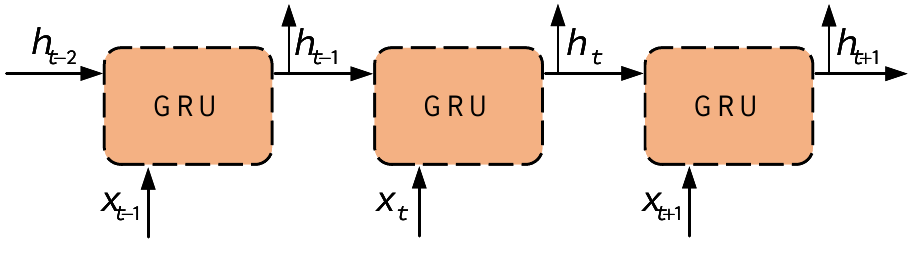
Figure 3. Circular structure of